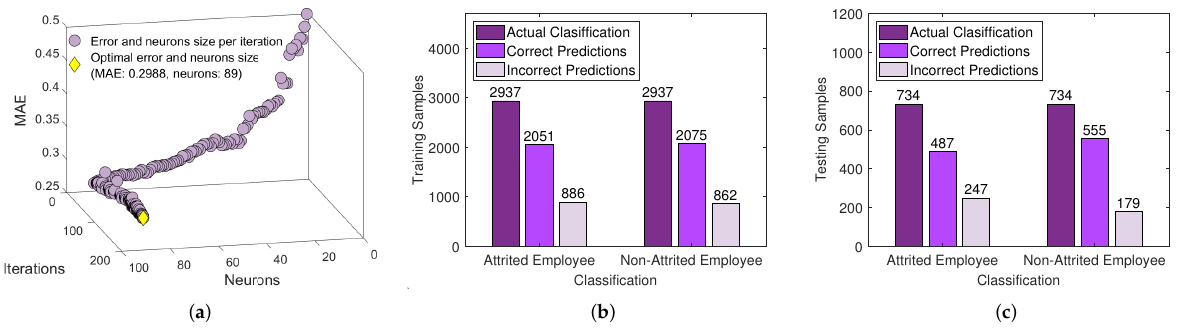
Figure 5. Training iterations and classification results of the FCI-WASD on EA.II. ( a ) EA.II: Training iterations; ( b ) EA.II: Training results; ( c ) EA.II: Testing